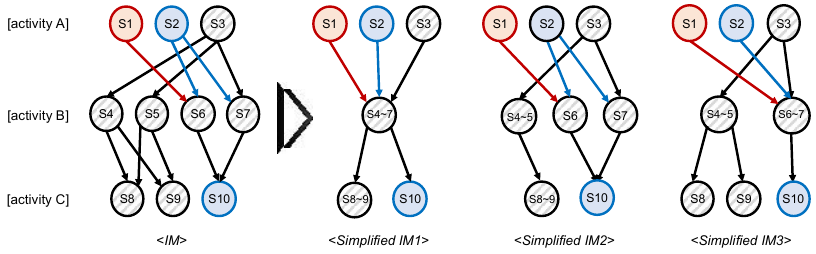
Figure 4. An Example of the simplified models with different conditions.